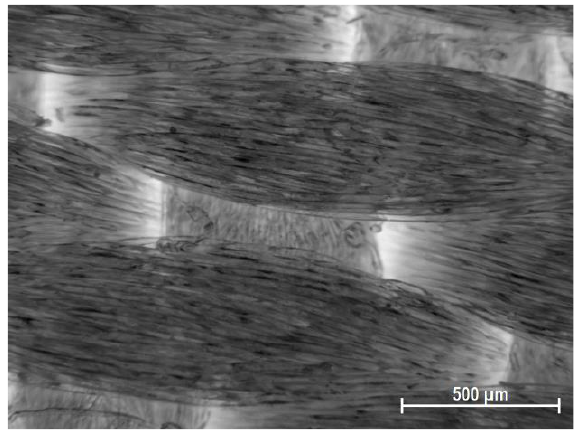
Figure 5. Optical microscope image of multifilament.